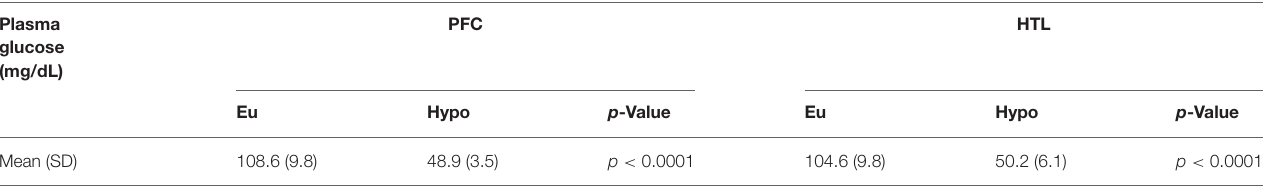
TABLE 1 | Mean plasma glucose values for both volumes of interests (VOIs) during euglycemic and hypoglycemic glucose clamps in patients with type 1 diabetes ( N = 6). Plasma glucose